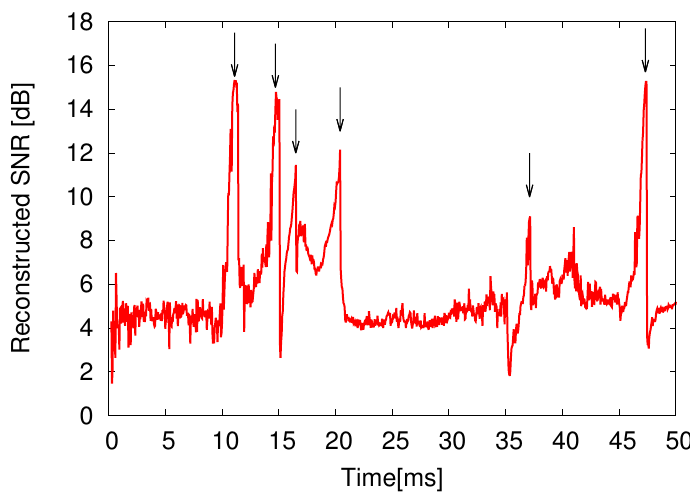
Figure 18. Temporal change of reconstructed SNR (CR = 4).